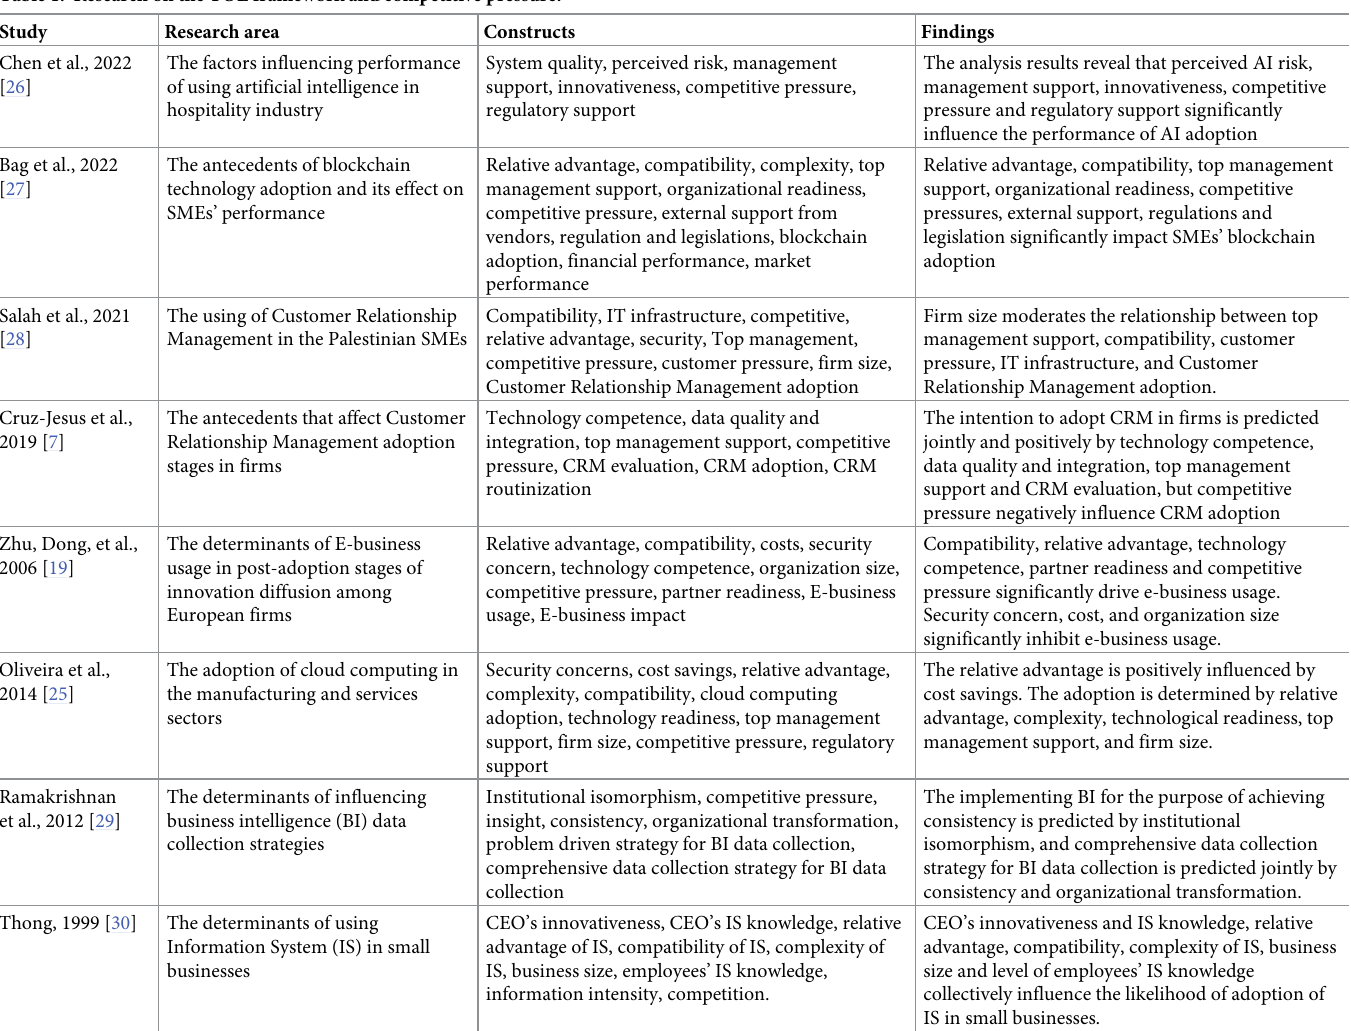
Table 1. Research on the TOE framework and competitive